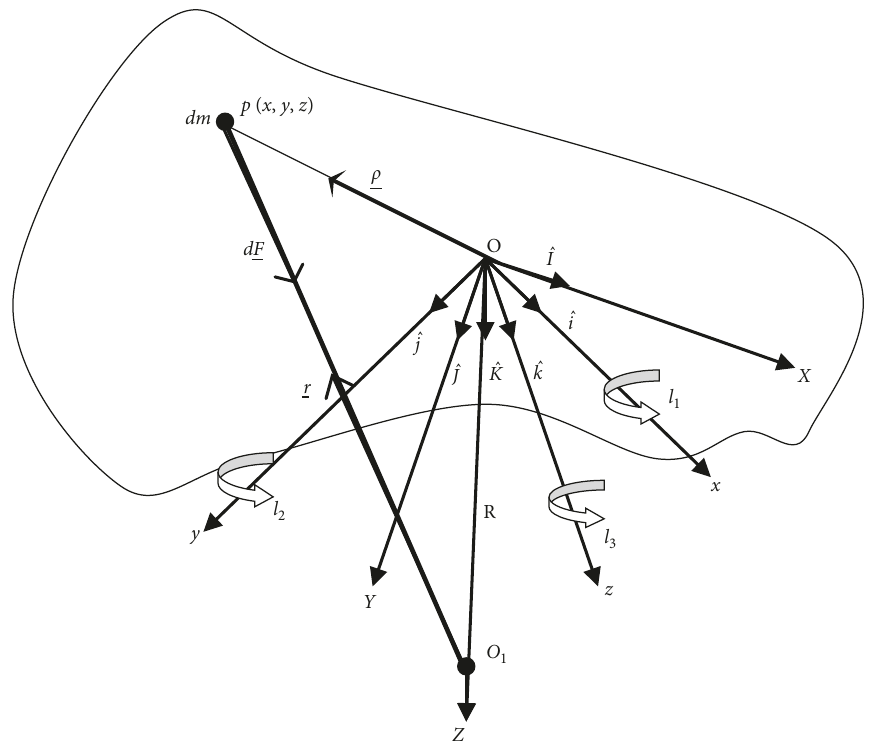
Figure 1: Force and couples’